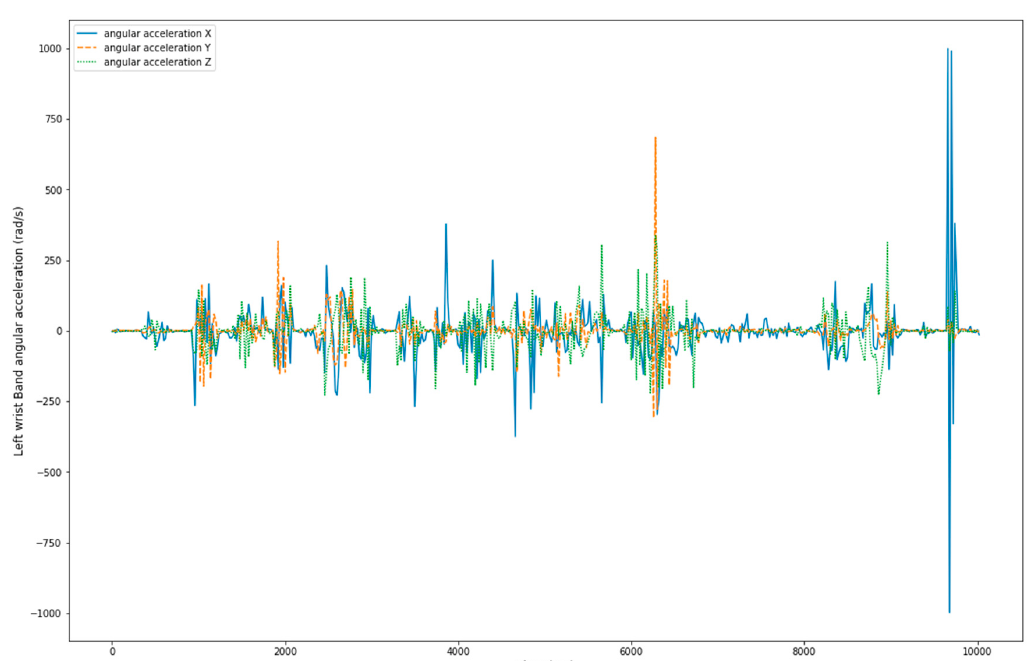
Figure 4. Tri-axial angular acceleration of participant 1.